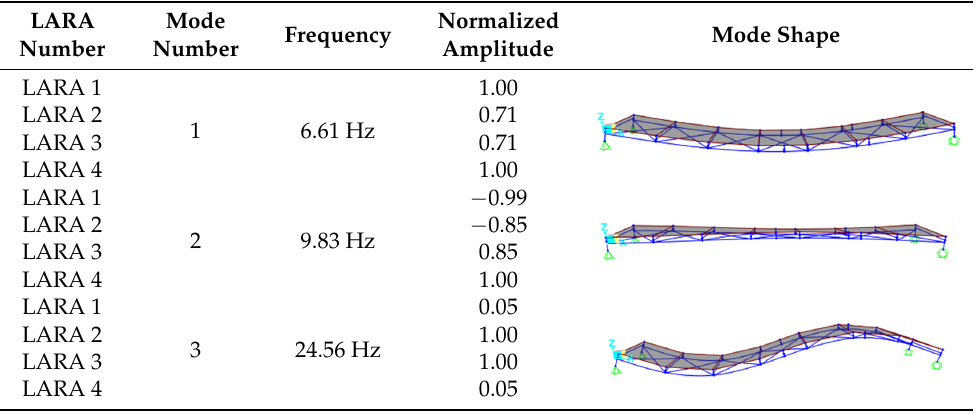
Table 6. Normalized mode shapes of SAP2000 from the modal analysis load case.